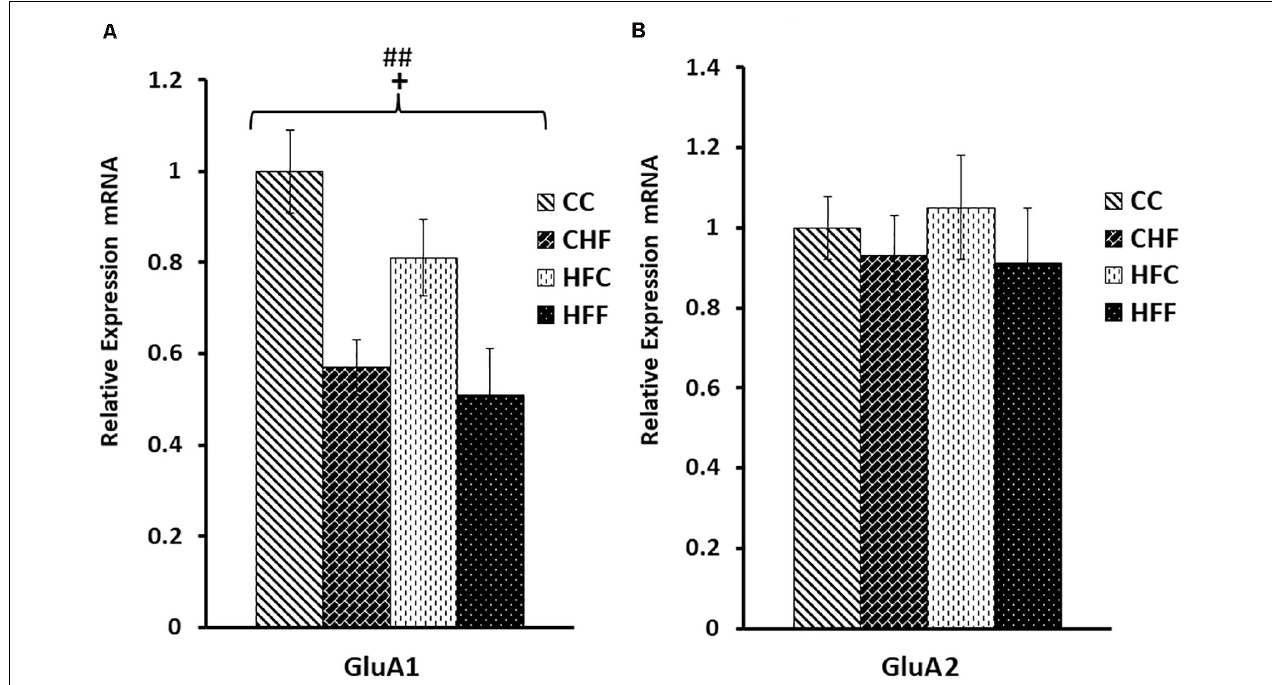
FIGURE 8 | Glutamate AMPA receptor subunit mRNA expression in the hippocampus. Hippocampal mRNA expression for the glutamate AMPA receptor subunits, GluA1 and GluA2, was measured in the CC, CHF, HFC, and HFF groups using qRT-PCR. Values are expressed in relative units where the CC group is set to 1. (A) GluA1 subunit expression was significantly reduced in response to both the maternal ( F ( 3 , 39 ) = 4.06, P = 0.047) and post-weaning HF diet ( F ( 3 , 39 ) = 8.04, P = 0.008). (B) No significant changes were measured for hippocampal GluA2 mRNA expression using two-way ANOVA. Values are means + SEM ( n = 16 for each group). + P < 0.05 (significant maternal diet effect); ## P < 0.01 (significant post-weaning diet